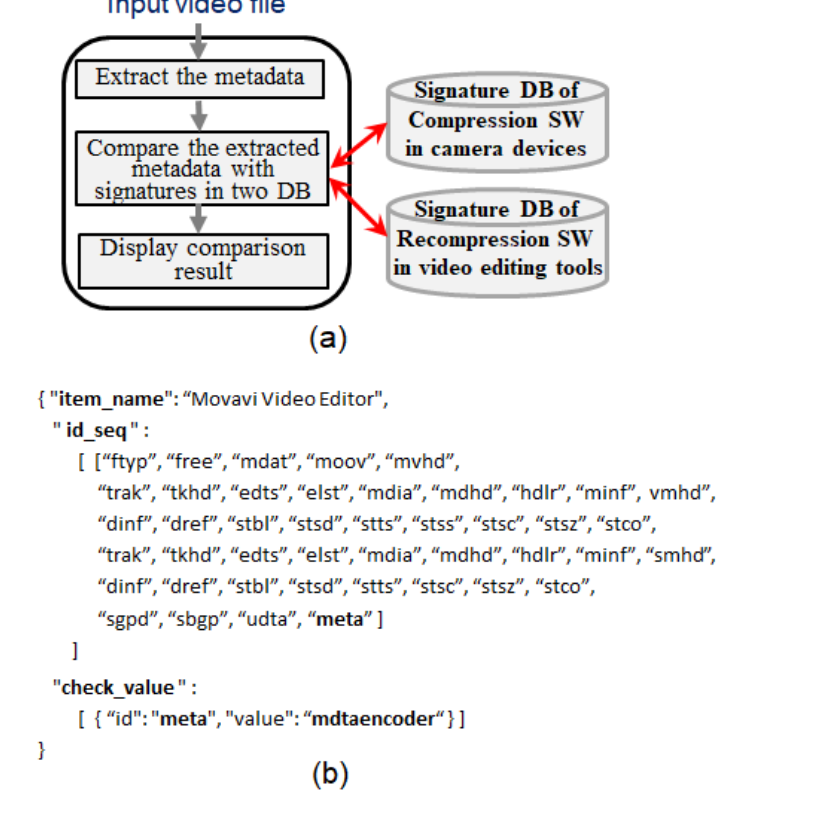
Figure 2. Outline of Integrity Analysis: ( a ) Modules of integrity analysis function and ( b ) signature example of video editing